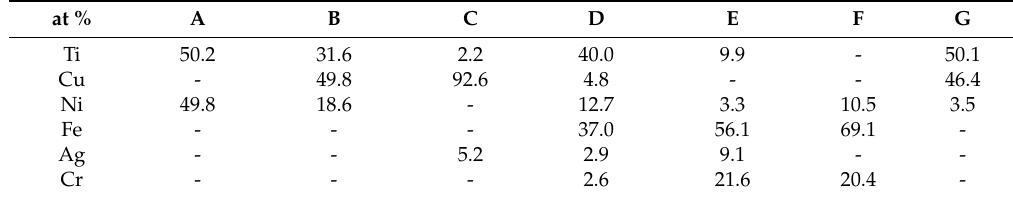
Figure 5. SEM BEI cross sections of Ti 50 Ni 50 /Cusil-ABA/25 μ m Cu foil/BAg-8/316L SS specimen infrared brazed at 850 °C for 300 s: ( a ) the Ti 50 Ni 50 substrate side; ( b ) the 316L SS substrate side. (TiNi: Ti 50 Ni 50 substrate, 316L: 316L SS substrate). Table 3. EDS chemical analysis results in Figure 5.